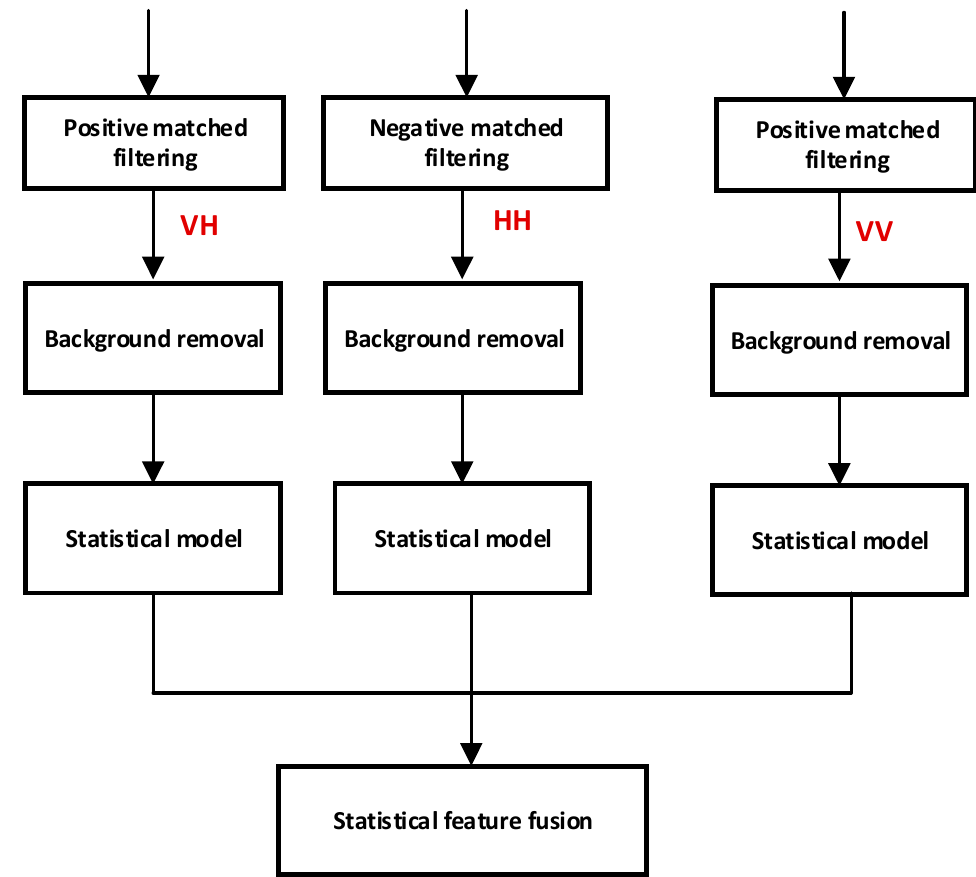
Figure 5. The flow chart of fully polarimetric radar signal processing.